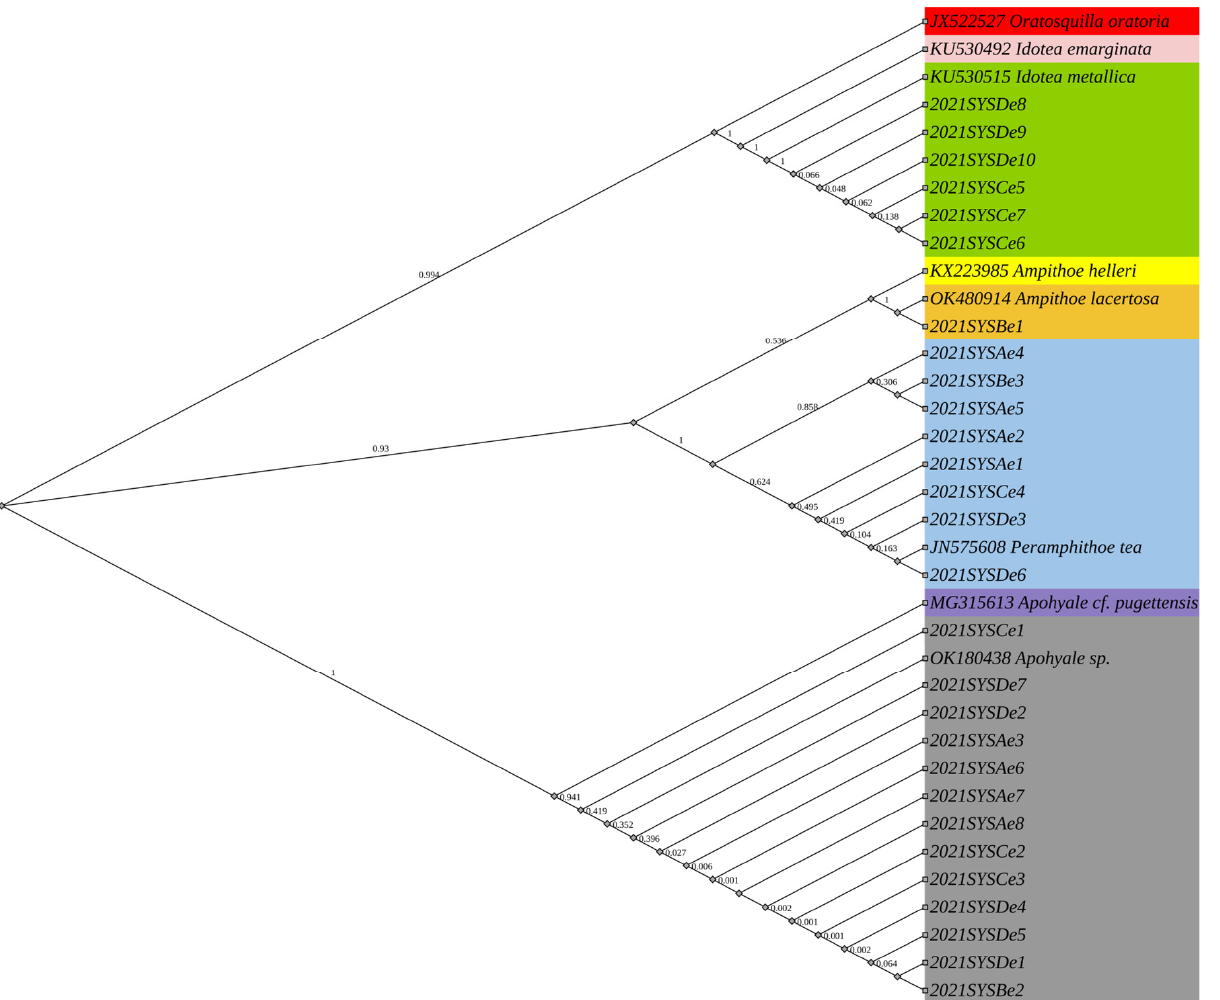
Figure 5. MCL phylogenetic tree of the epizoans analyzed in this study; 1000 bootstrap replicates were used to verify the support rate of each node in this tree.